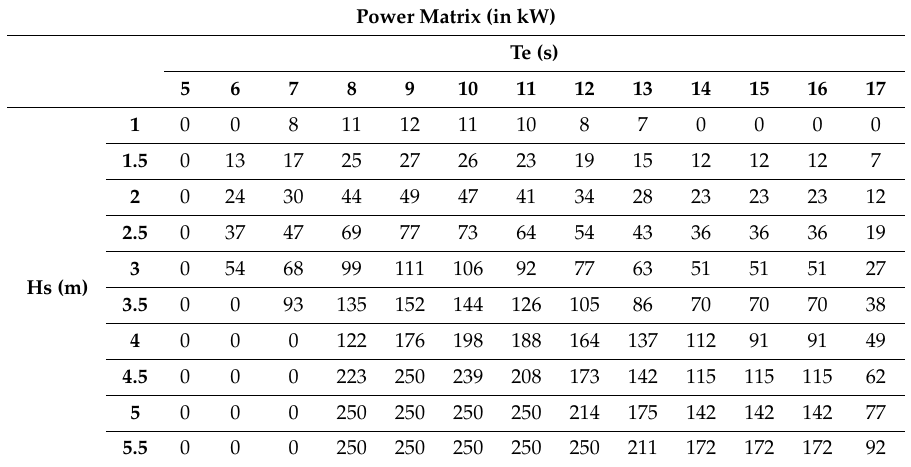
Table 3. Power matrix of D2, Hs being the significant wave height and Te the wave energy period [60].